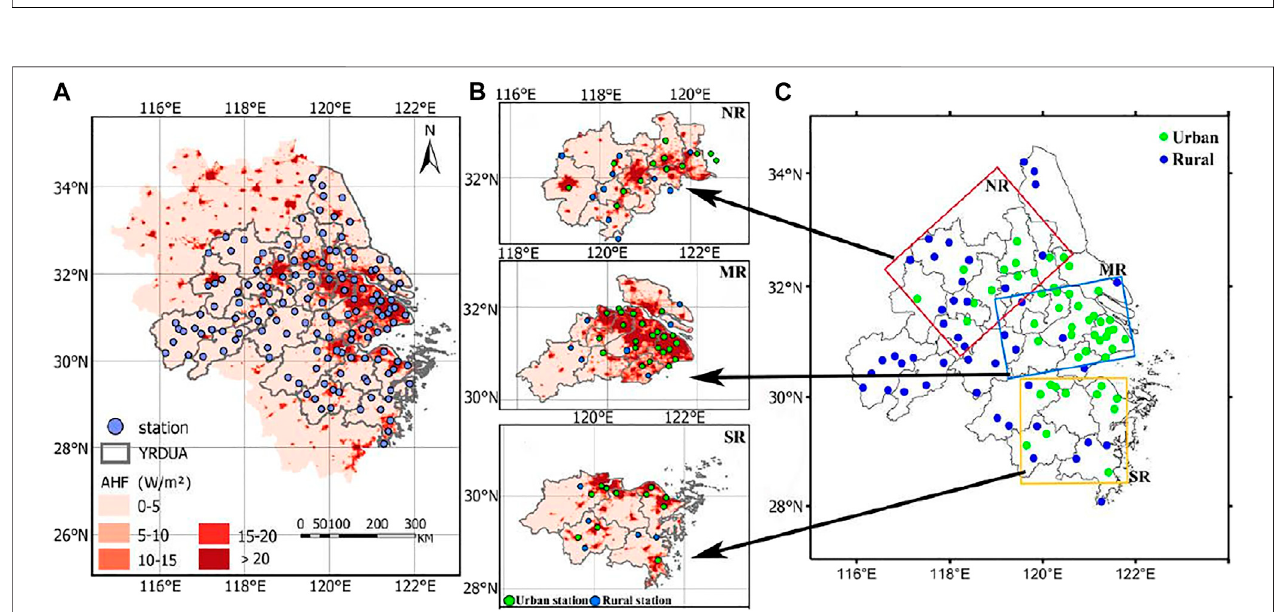
FIGURE2|(A) Spatialdistributionofanthropogenicheatinsummer2016intheYangtzeRiverDeltaregion. (B) Averageanthropogenicheat fl ux(W/m 2 )distribution within 5 km around stations in three sub-regions of YRDUA. (C) Three sub-regions of YRDUA and the classi fi cation of urban and rural stations.